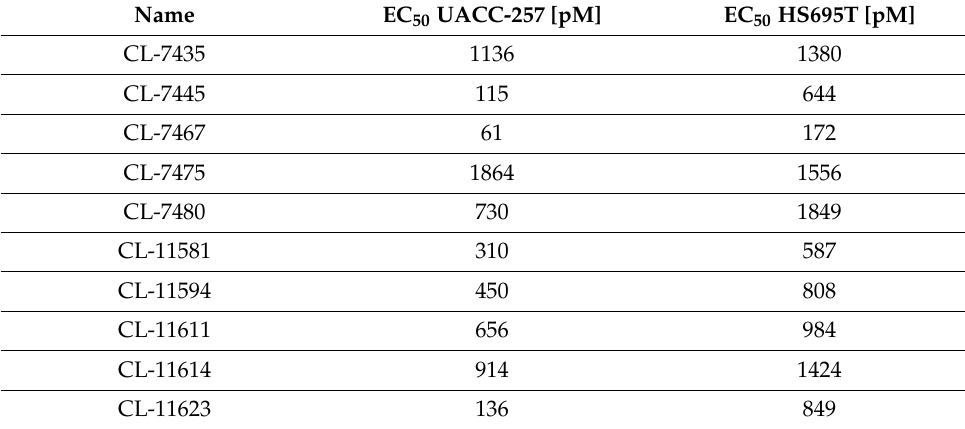
Table 5. EC50 values based on cytotoxicity data from selected